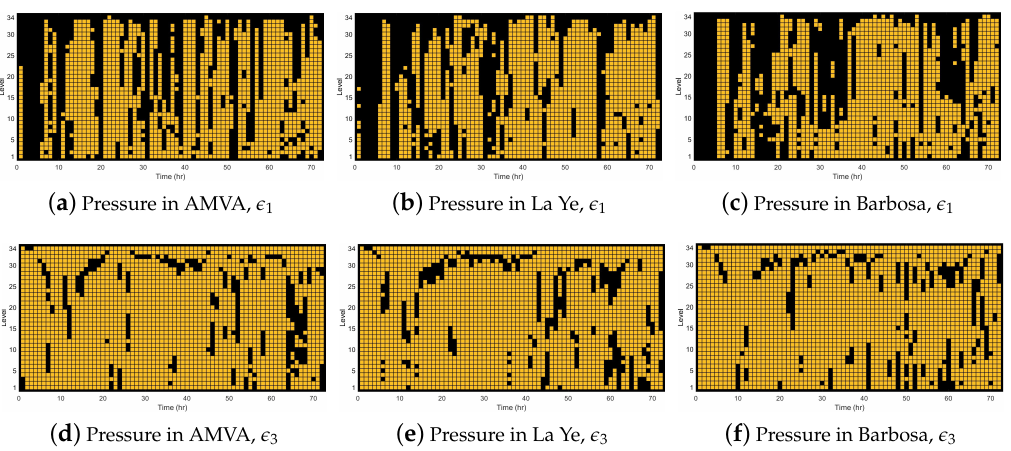
Figure 13. Rank test for the variable pressure with perturbation from (cid:101) 1 and (cid:101) 3 on time and levels. The yellow squares represent that the null hypothesis was not rejected, the black squares that it was rejected. ( a ) Rank test for perturbations from (cid:101) 1 and AMVA. ( b ) Rank test for perturbations from (cid:101) 1 and La Ye. ( c ) Rank test for perturbations from (cid:101) 1 and Barbosa. ( d ) Rank test for perturbations from (cid:101) 3 and AMVA. ( e ) Rank test for perturbations from (cid:101) 3 and La Ye. ( f ) Rank test for perturbations from (cid:101) 3 and